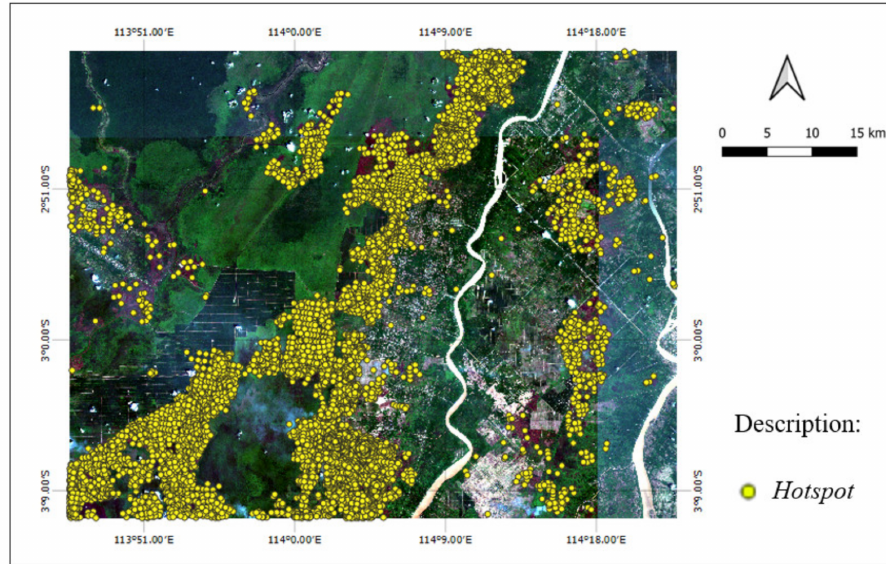
Figure 10. The distribution of hotspots at the research sites throughout